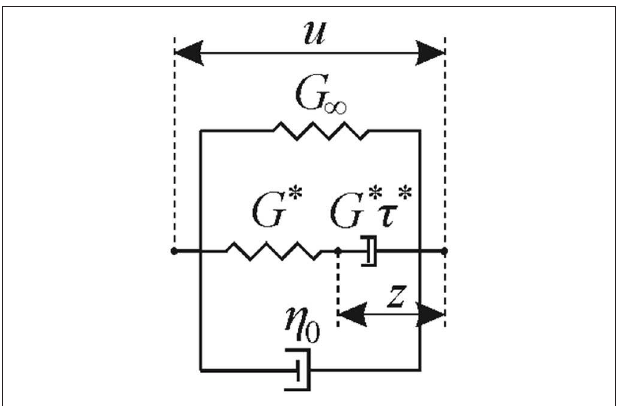
FIGURE 2 | Rheological model for the Kelvin–Maxwell solid. Notations are given in the text.